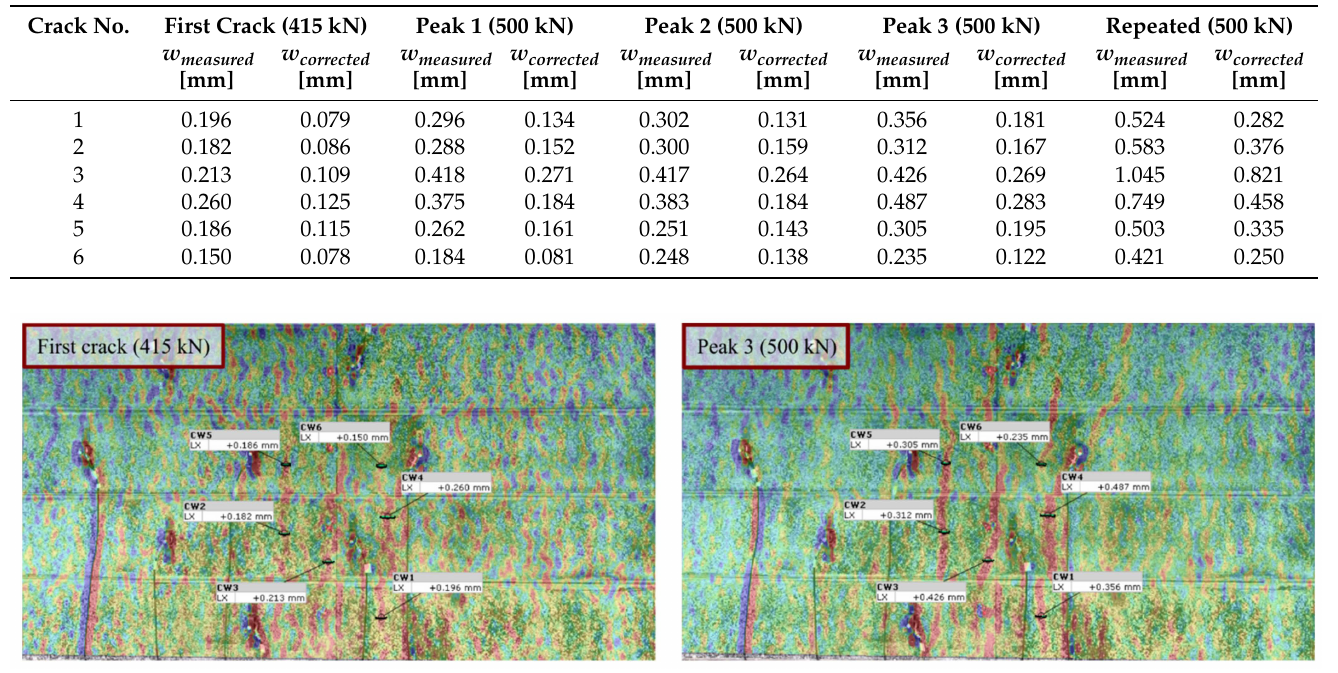
Figure 14. Measured crack widths at first crack (415 kN) and at Peak 3 (500 kN). The Eurocode (EC) demand for maximal crack width in SLS [22] ( w max = 0.2 mm